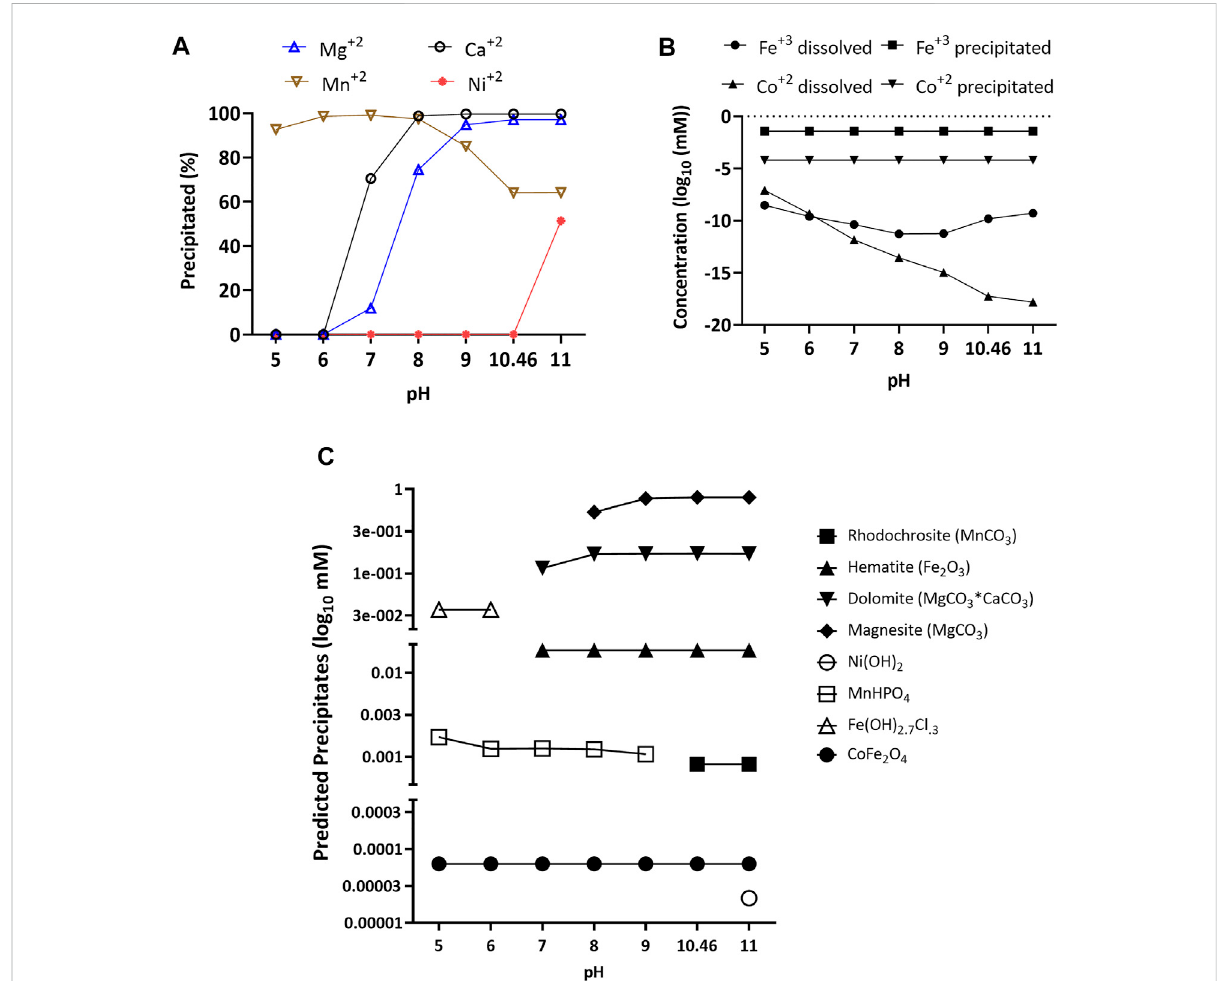
FIGURE 1 Percentage of magnesium, calcium, nickel, and manganese precipitated (A) , concentration dissolved and precipitated for iron and cobalt (B) , and predicted precipitates (C) of calcium, magnesium, cobalt, nickel, and iron over a pH range of 5 – 11 with an ionic strength of 0.73 M. Data was obtained using Visual Minteq 3.1 equilibrium